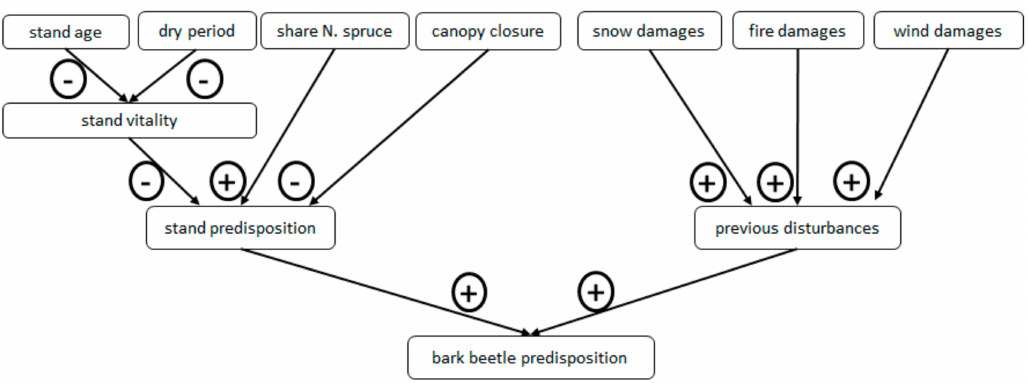
Figure 2. Influence diagram for the bark beetle disturbance network (“+” and “ − “ indicate a positive or negative relation of a pair of nodes,